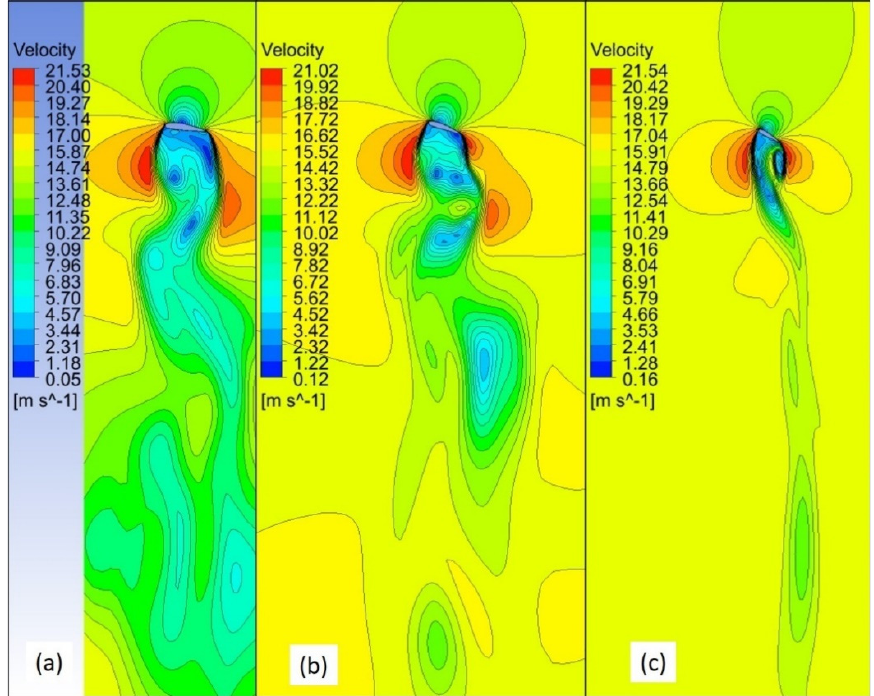
Figure 9. Velocity profile and wake formation at three locations of the span, ( a ) 20% chord from root, ( b ) 50% chord length from rot, ( c ) 90% chord length at 15 m/s (8° angle).